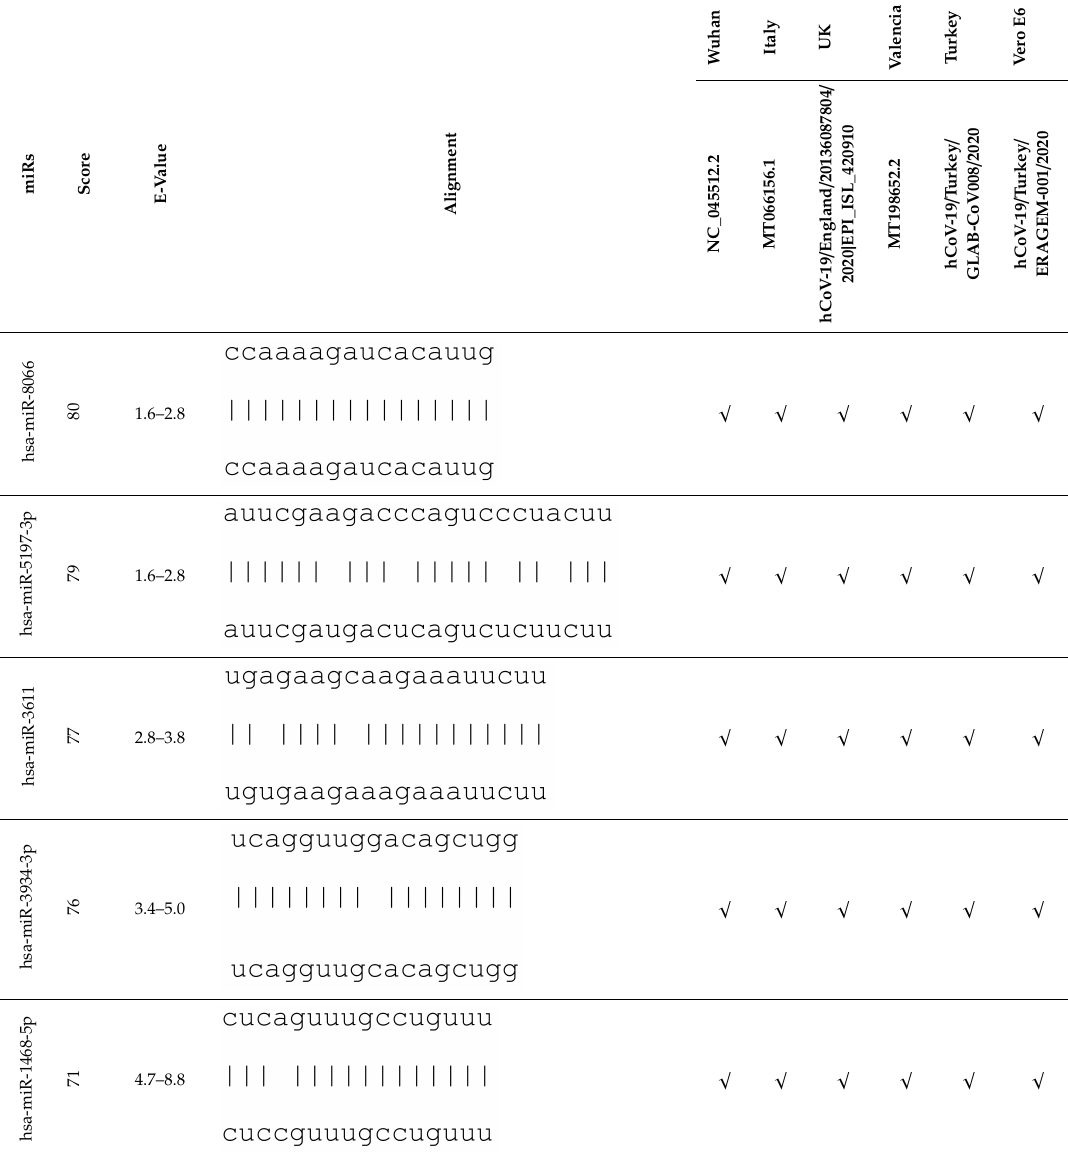
Table 1. Similar microRNA (miR) sequences found in SARS-CoV-2-released genomes from di ff erent geographical